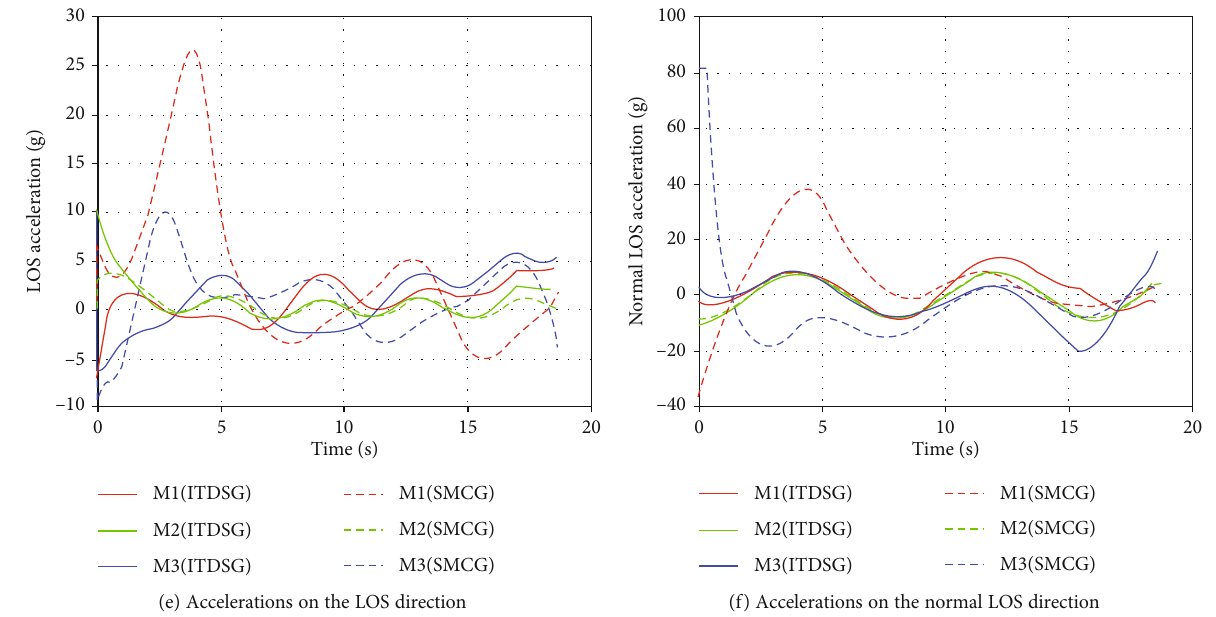
Figure 9: Simulation curves for a highly maneuvering